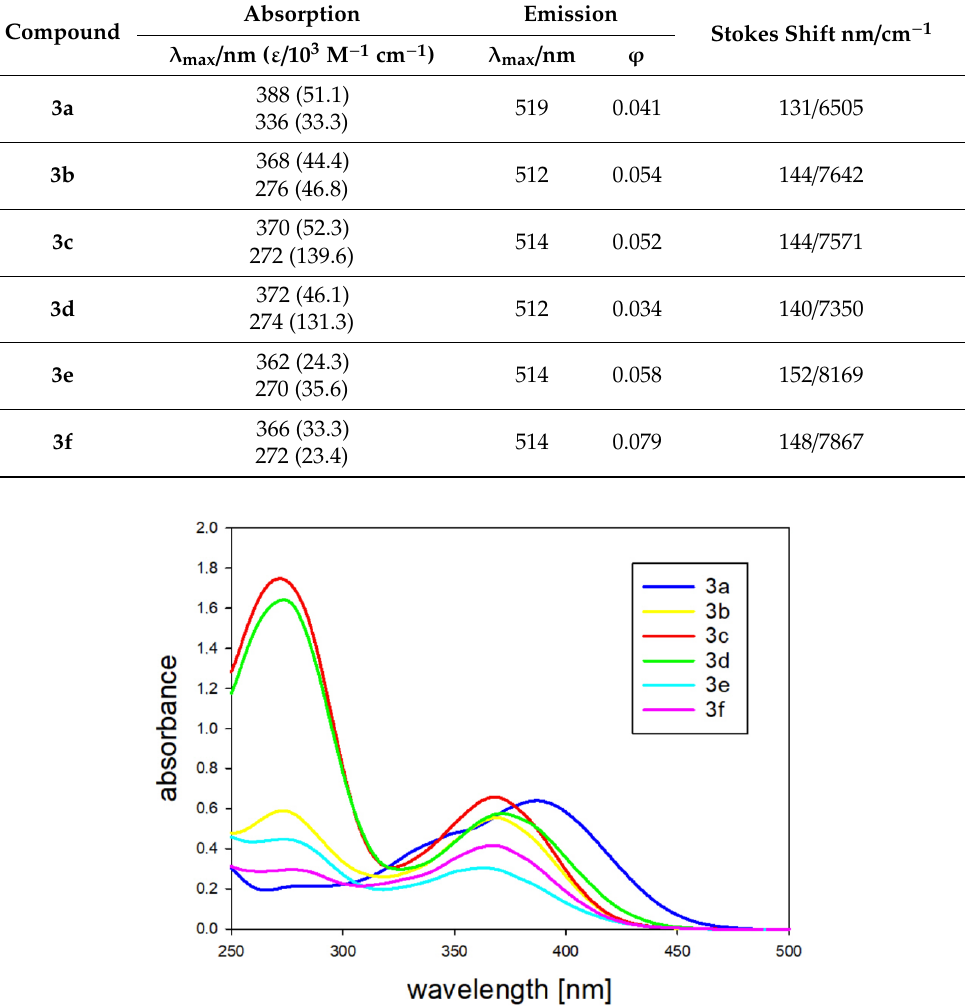
Table 1. Fluorescent and absorption properties of the Schiff bases 3a – f in ethanol. Compound